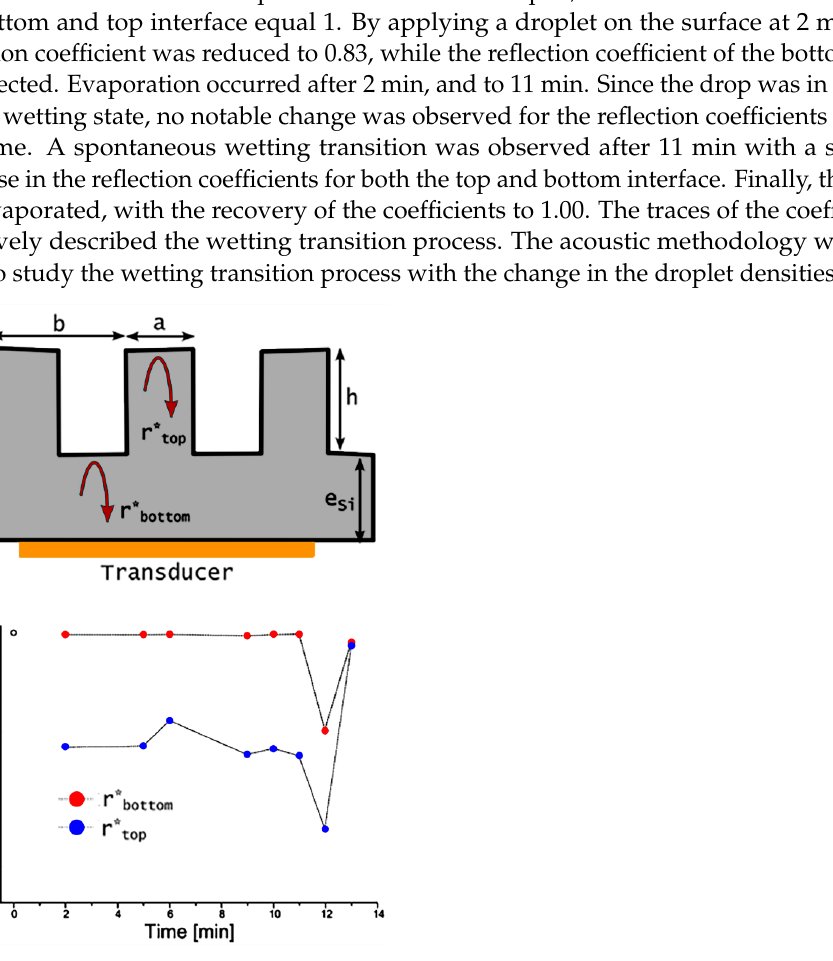
Figure 11. ( a ) Schematic diagram of the experimental setup for the acoustic methodology. ( b ) The evolution of reflection coefficients on the top and bottom interface with the droplet evaporation. Reprinted with permission from Ref. [106]. Copyright@2013, Langmuir.